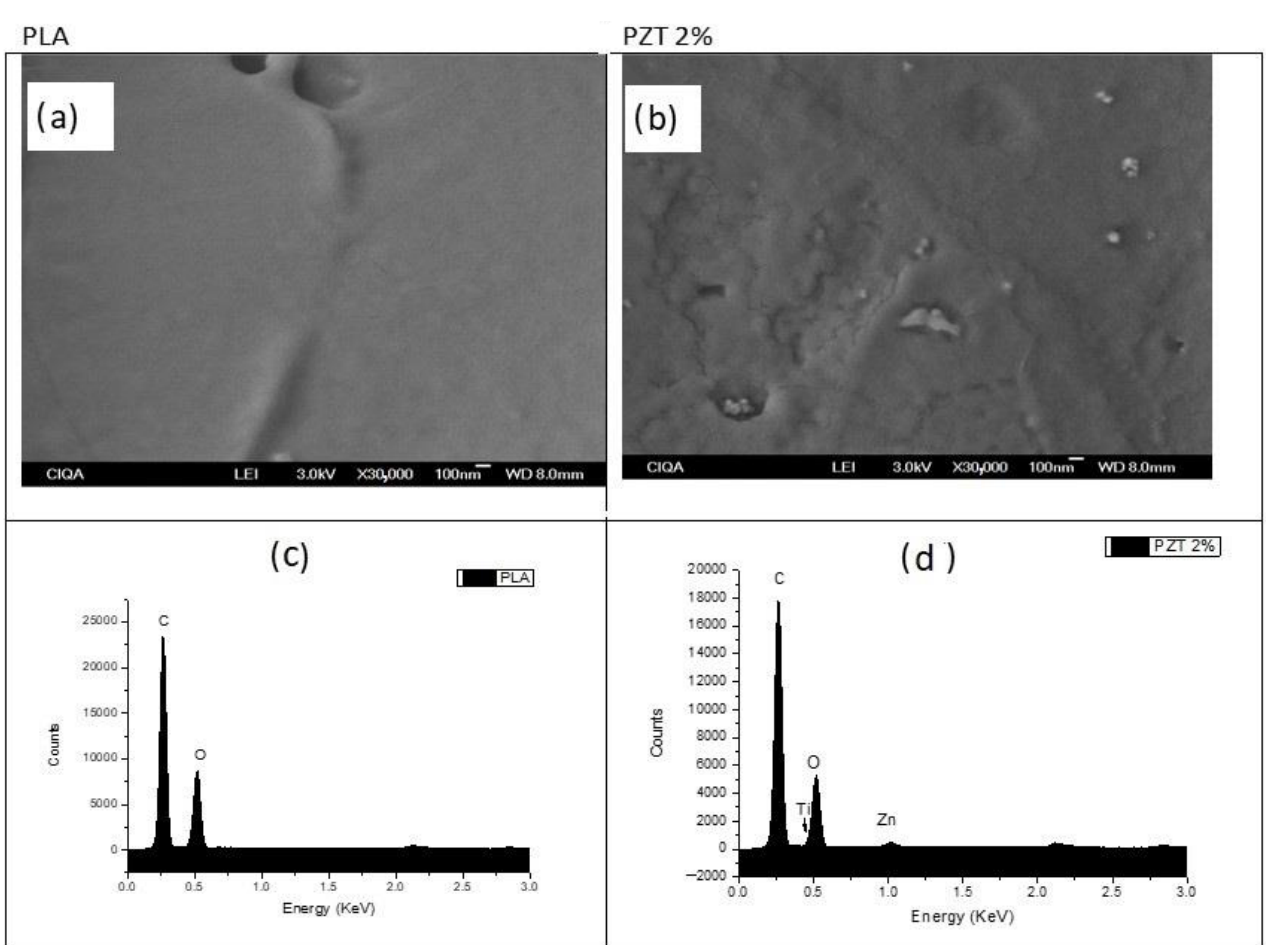
Figure 5 . SEM images of (a) PLA and (b) 2% PZT samples at 30,000×. EDS analysis of (c) PLA and ( d ) 2% PZT (d) 2% PZT samples.